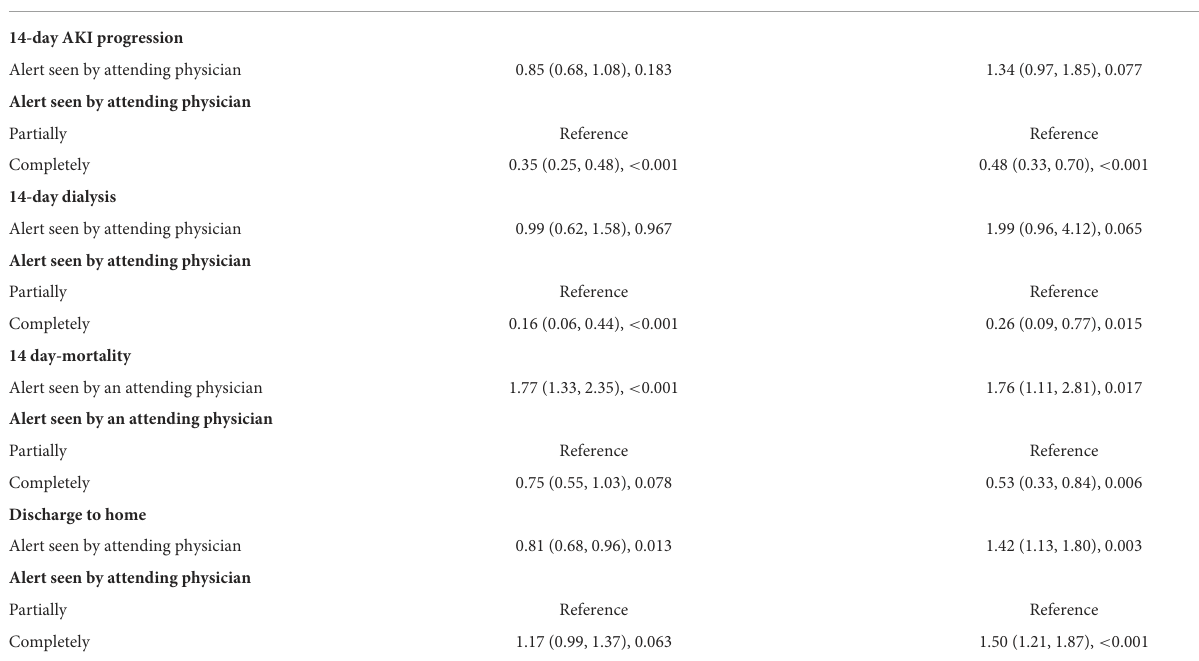
TABLE 2 Univariate and multivariate logistic regression